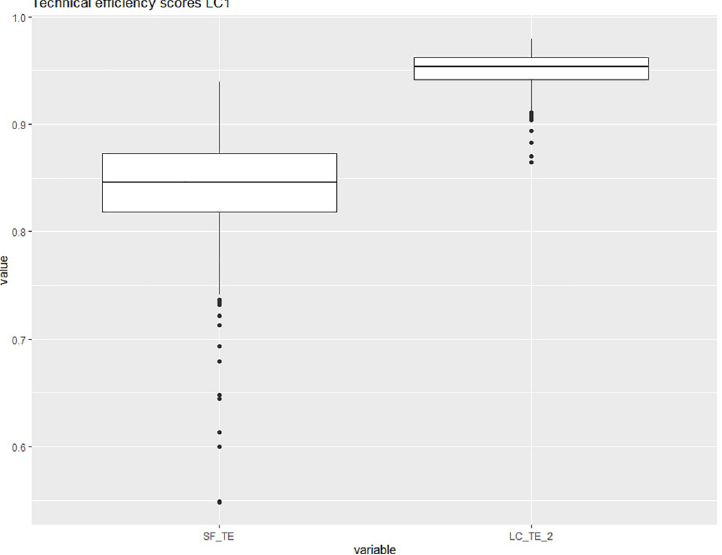
Fig 4. Distributions of the technical efficiency scores for the stochastic frontier (left) and the latent class model based only on the observations belonging to latent class one. Source: Own illustration.